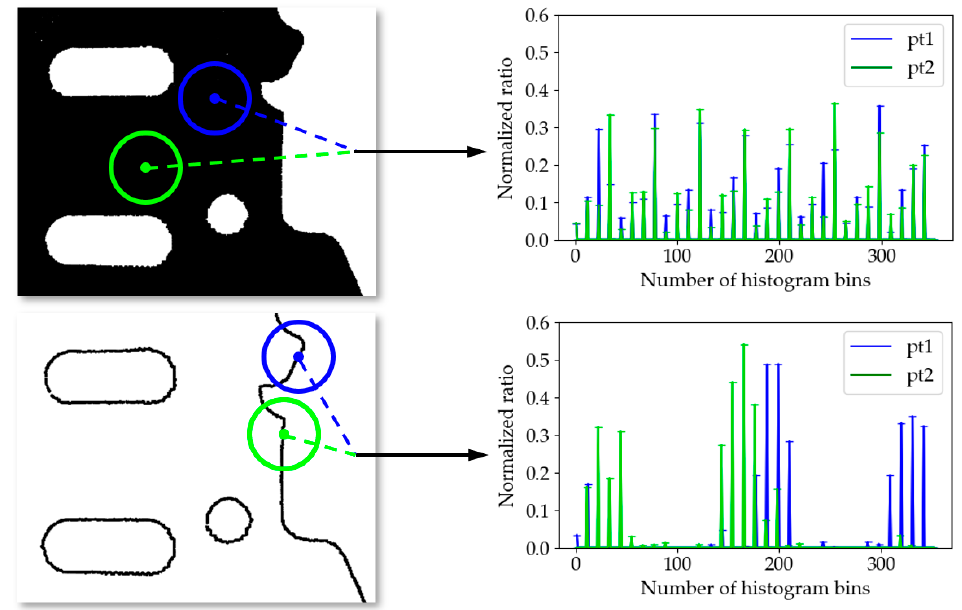
Figure 8. Comparison results of the uniqueness of descriptors between a planar point cloud and its corresponding boundary point cloud. For each point cloud, we select two sampling points and calculate their SHOT descriptors. The histograms show the differences between the two descriptors.